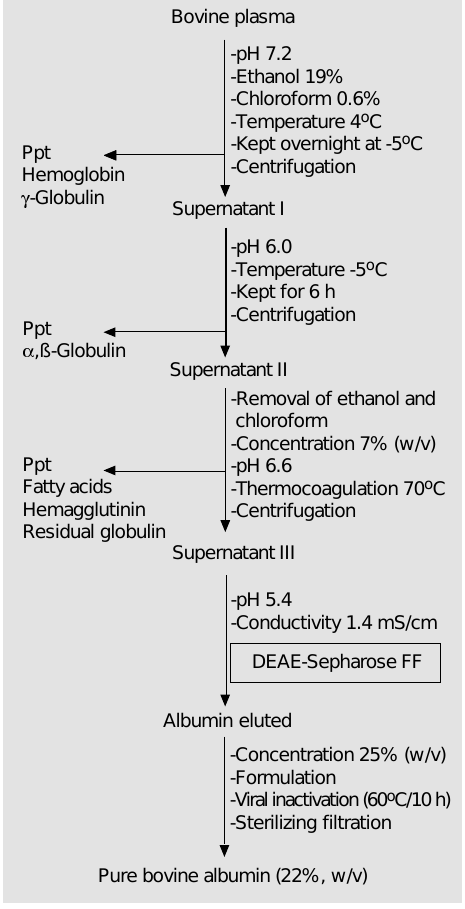
Figure 1. Schematic presenta- tion of bovine albumin purifica- tion. Ppt =